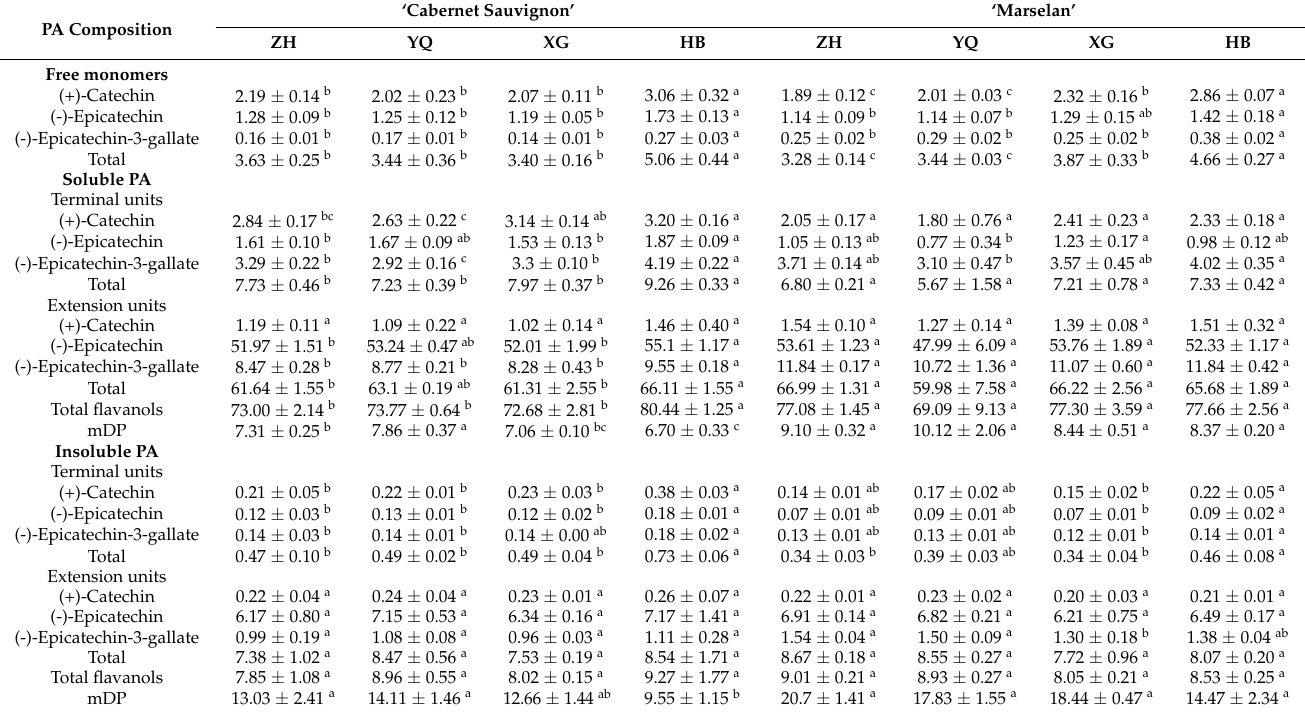
Table 3. The composition and content of soluble PA and insoluble PA in the seeds from four sub- regions (mg/g.